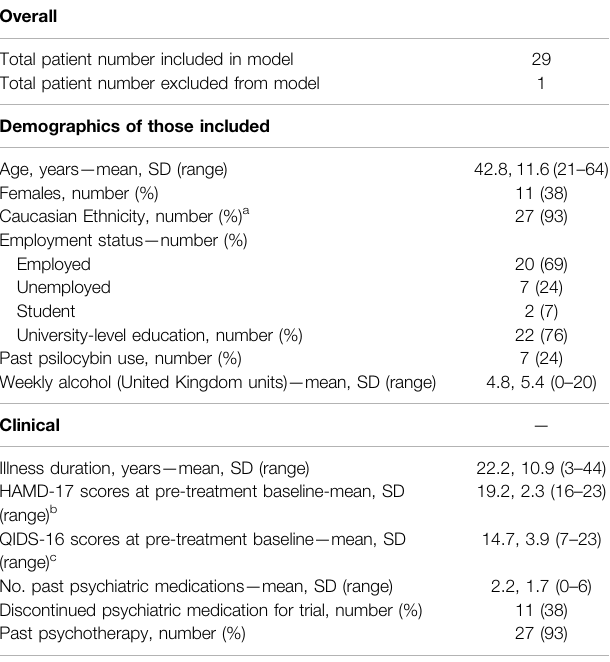
TABLE 1 | Demographic information of participants in the psilocybin arm of the trial. Overall Total patient number included in model 29 Total patient number excluded from